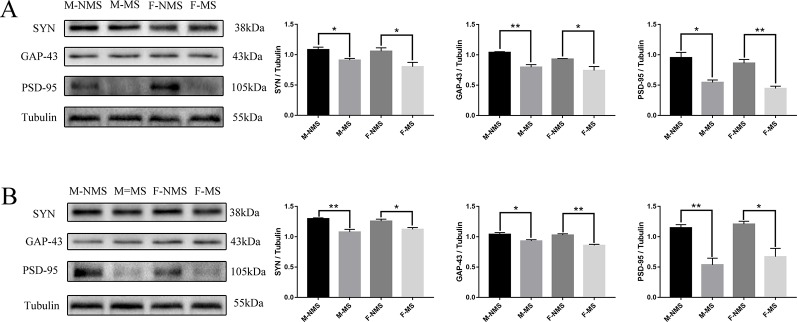
MS reduces the expression of synaptic-plasticity protein. (A) The bands of synaptic-plasticity proteins of SYN, PSD-95, and GAP-43 in the hippocampus by WB. Statistical results indicate the relative protein levels expressed by SYN, GAP-43, and PSD-95. (B) The bands of synaptic-plasticity proteins of SYN, PSD-95, and GAP-43 in cortex by WB. Statistical results indicate the relative protein levels expressed by SYN, GAP-43, and PSD-95. Statistical analyses are performed by two-way ANOVA followed by t-test. Data are presented as mean ± SEM, *p < 0.05, **p < 0.01, n = 3 per group.